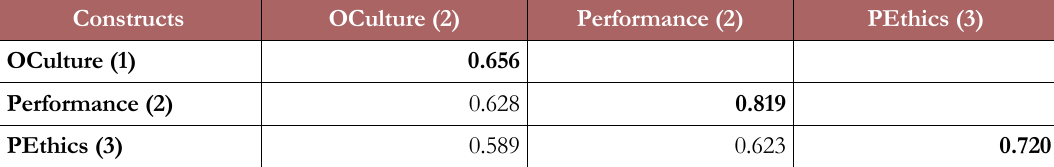
Table 5. Fornell-Larker Discriminant validity